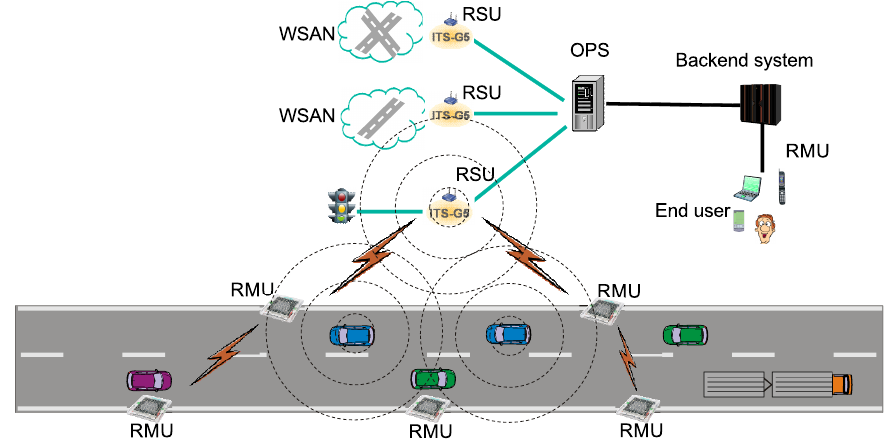
Figure 12. Simulation scenario representing an intelligent transportation system with road side marking units (RMUs) placed along the route. RSU, road side unit; OPS, open platform